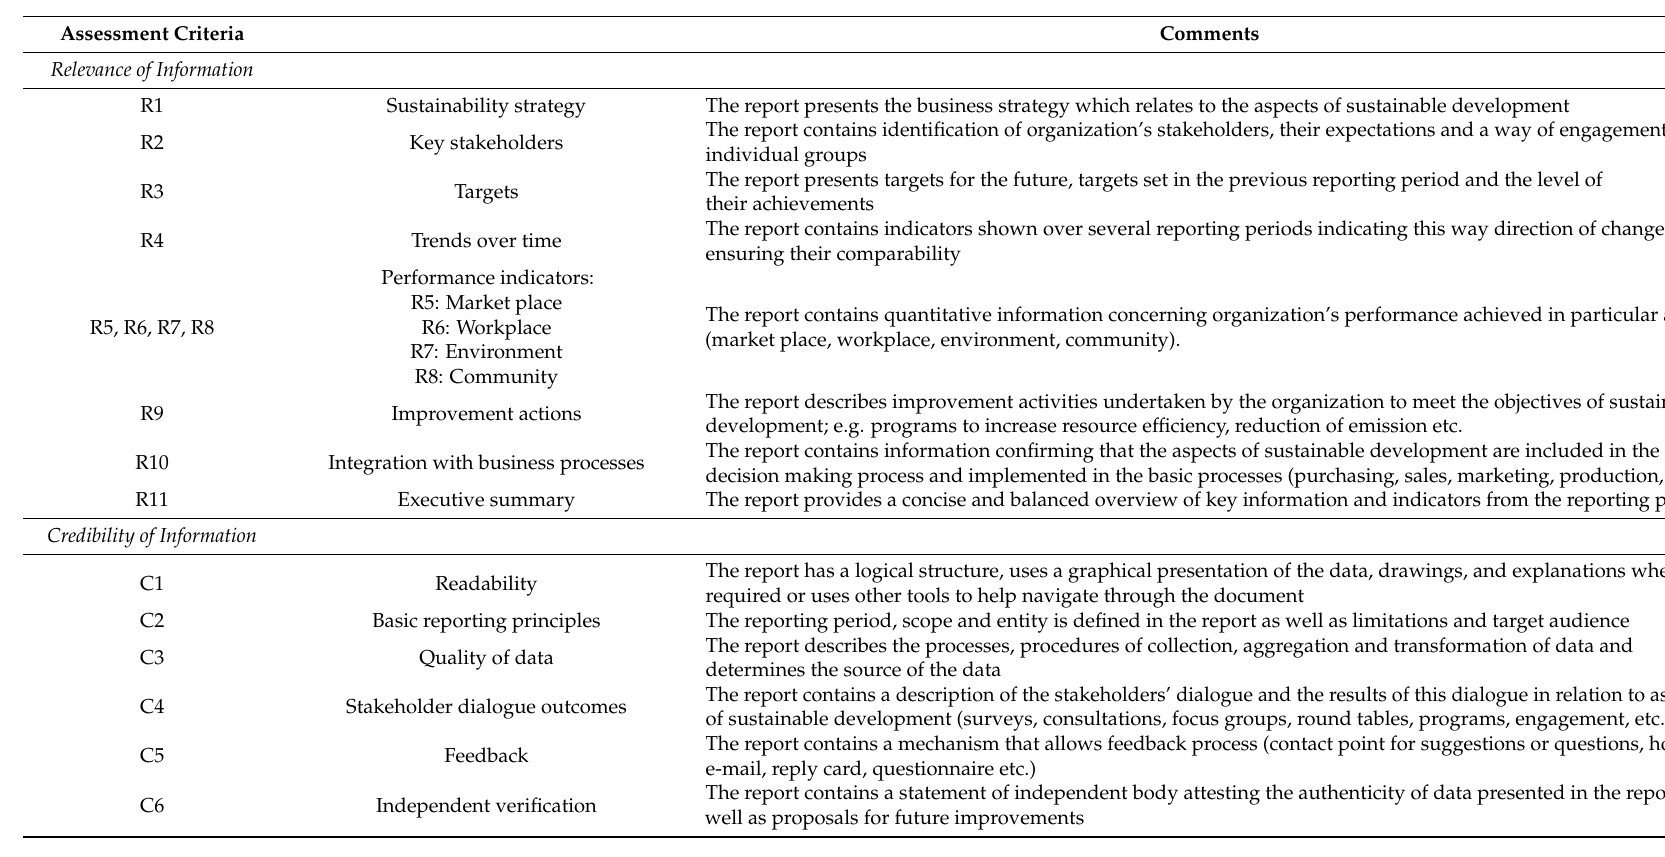
Table A3. Quality criteria coming from